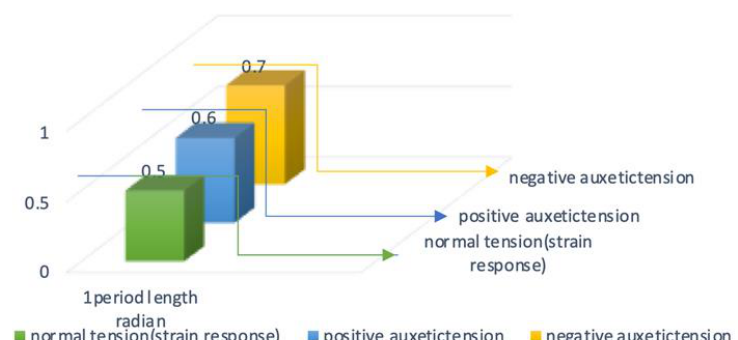
Figure 13. Analysis of sensor stress–strain signal results according to braiding conditions.